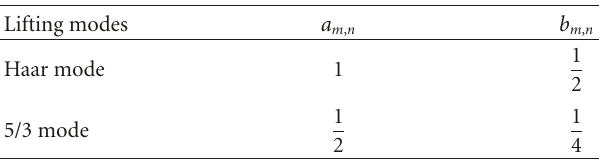
Table 1: Scaling factors in the P and U steps in di ff erent lifting